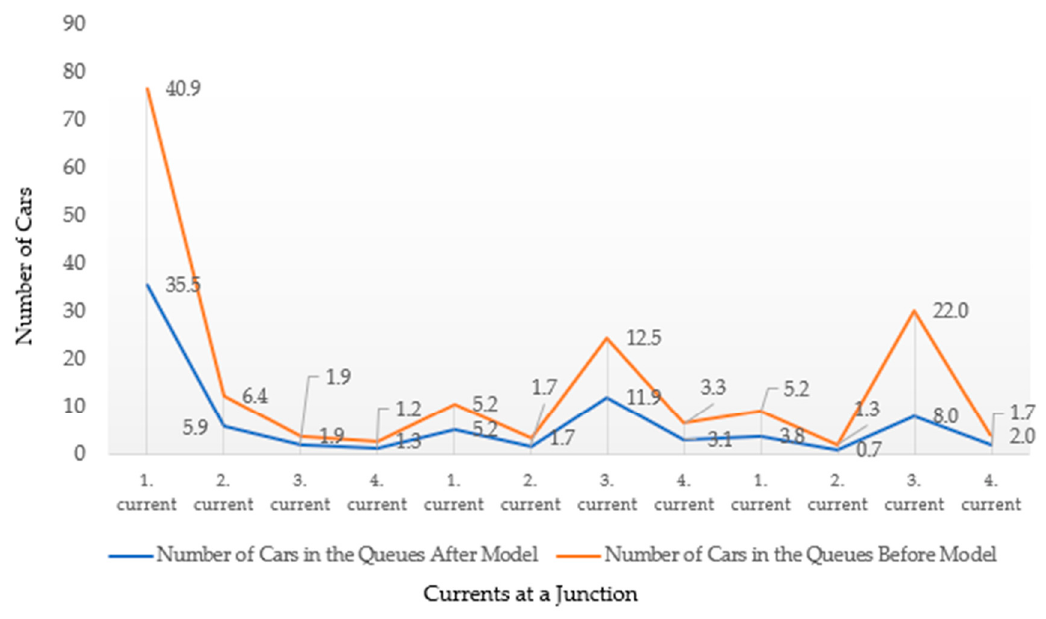
Figure 13. The change in the number of vehicles in the queues before and after the proposed model.